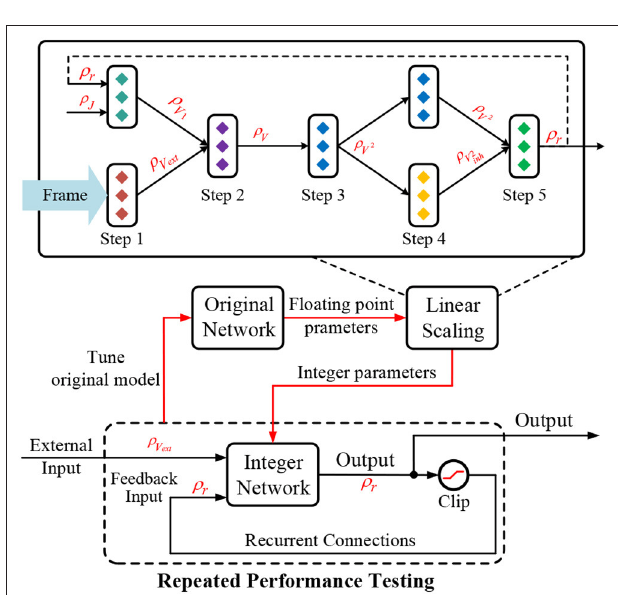
FIGURE 6 | Quantization with a linear scaling chain rule in the feedforward pass corresponding to the five execution steps mentioned in section 4.2 and an extra constant-scaling restriction in the feedback